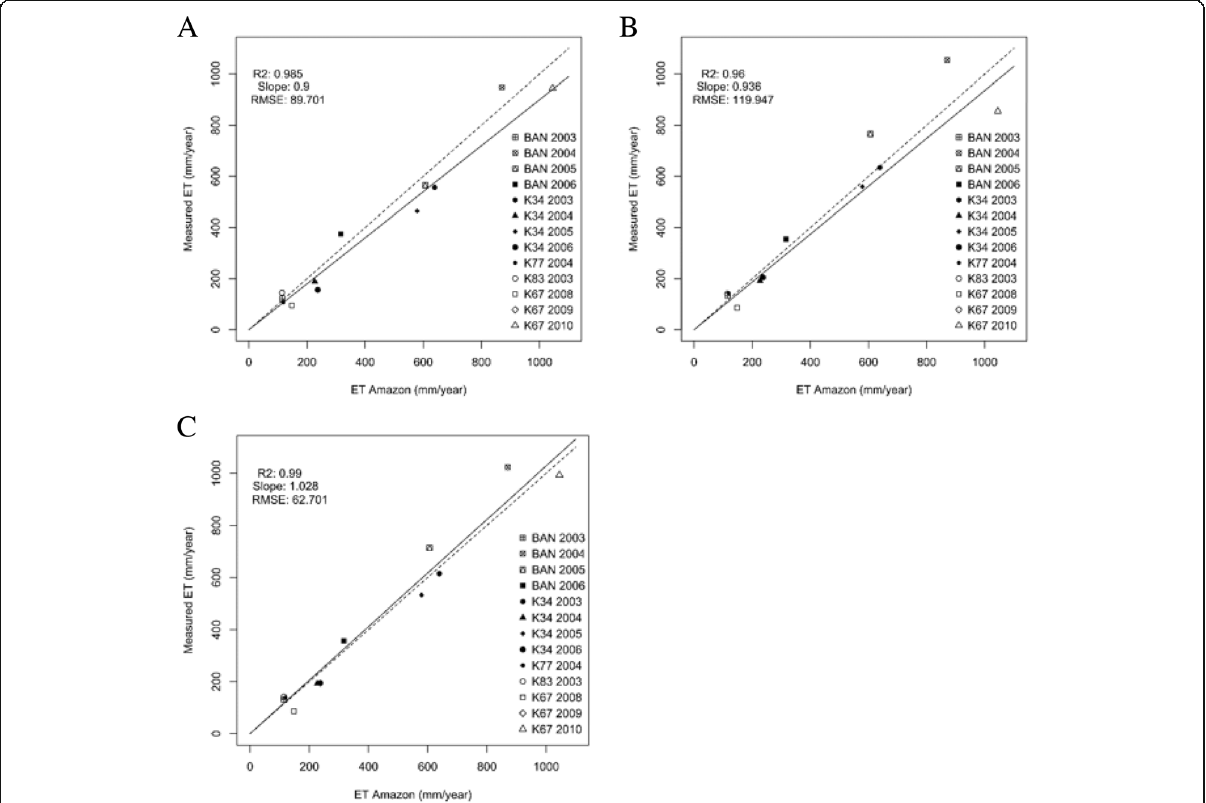
Fig. 4 Scatter diagram of accumulated ET measured by flux towers plotted against ET-Amazon values for a 2-month or longer integration period, for each of the three ET methods: (1) direct measurements ( a ), (2) the residual of energy balance ( b ), and (3) the Bowen ratio ( c ). The one-to-one line (dashed) and the trend line (solid) are also